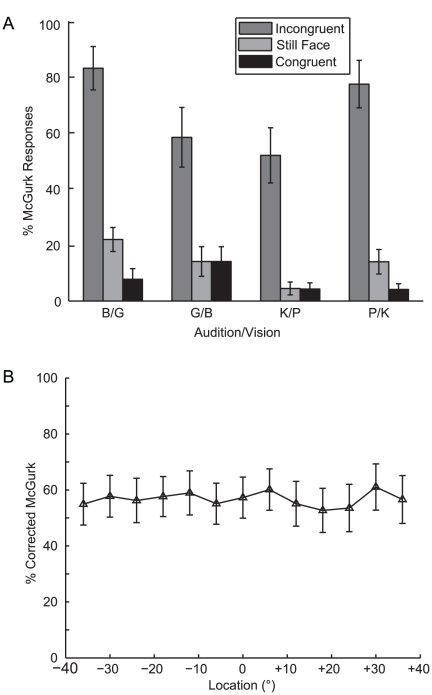
McGurk interference is spatially independent.(A) McGurk interference rates are plotted as a function of stimulus condition and audiovisual pair. Responses indicative of McGurk interference significantly increased in the Incongruent condition compared to the Still Face and Congruent conditions. (B) Corrected McGurk interference rates are plotted as a function of location. The data suggest that speech related cues operate independently of spatial information. Corrected McGurk interference rates were calculated by subtracting the %McGurk Responses in the Still Face Condition (light-gray bars) from the Incongruent condition (dark-gray bars). (N = 11, means ± SEM).